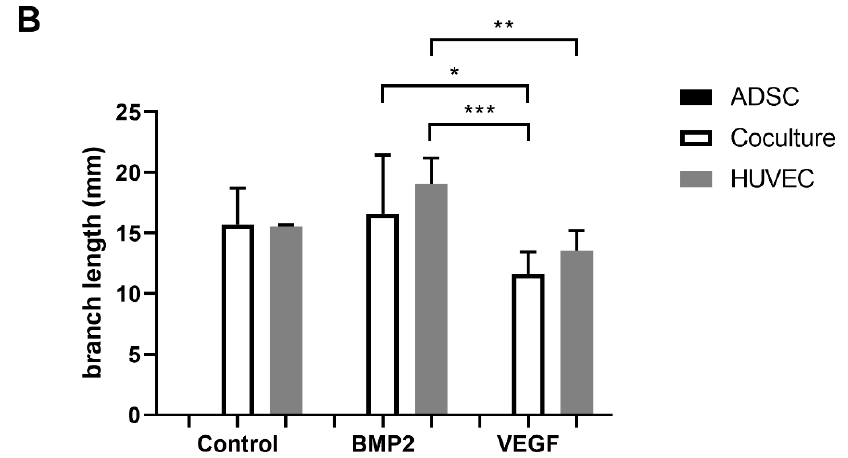
Figure 4. Compared to the control group, no effect of BMP2 or VEGFA165 was observed considering the branch number and length ( A , B ). BMP2 seems to be advantageous compared to VEGFA165 concerning the branch number and length. Statistically significant differences between the experimental groups are indicated for * p ≤ 0.05, ** p ≤ 0.01 and *** p ≤ 0.001.